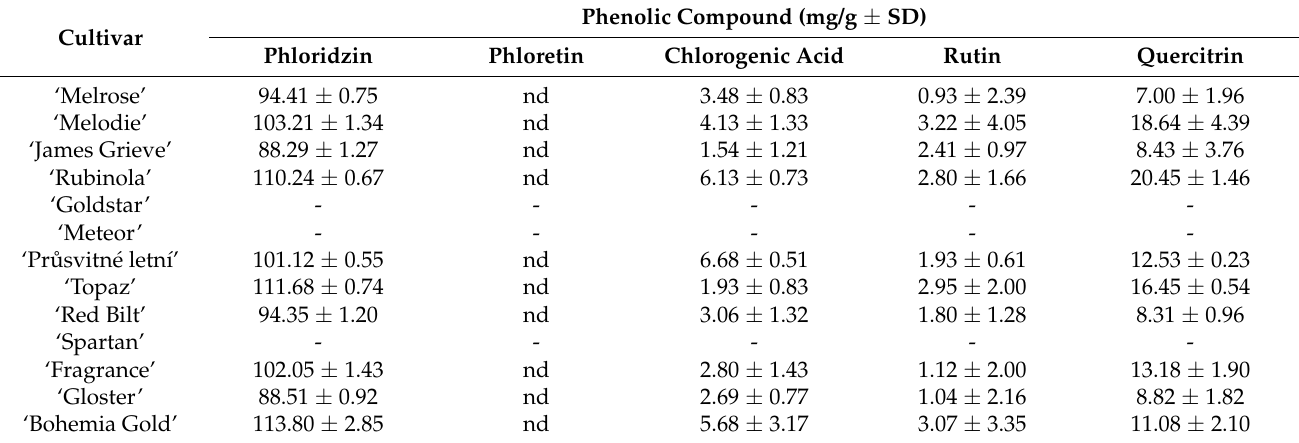
Table 5. Content of phenolic compounds in buds of nine cultivars (all values in mg/g of dried weight